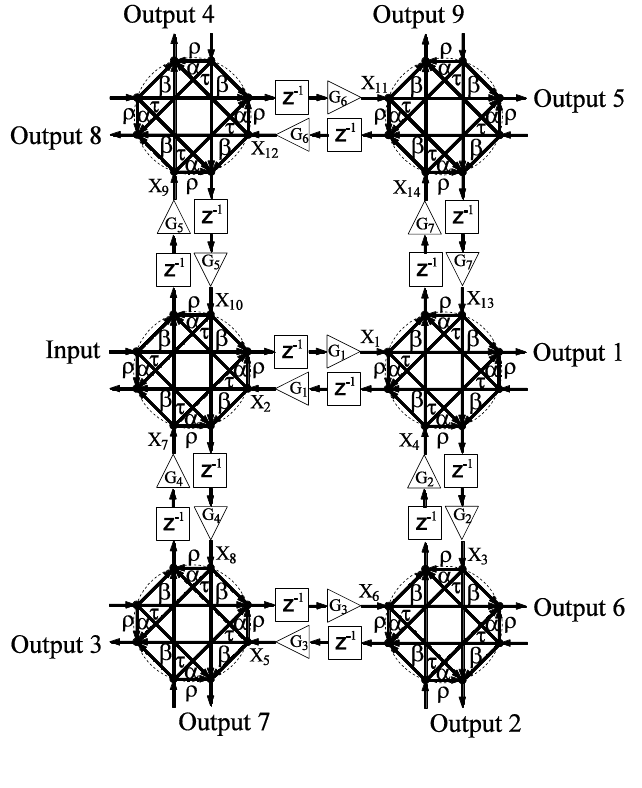
Figure 4. Network diagram of structure IV. Transmitted,  , reflected,  , right- directed,  , and left-directed,  , coupler coefficient components. Photonic channelizer enabled by 6 four-port couplers, ....)3,2,1(  iG represent gain (triangles), 1  Z represent i unit delay (blocks), and X are internal states. Arrows indicate signal i